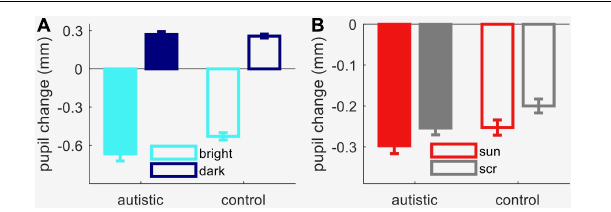
FIGURE 3 | Results from Experiment 2 (autistic and comparison children). (A) Peak pupil response to luminance increments and decrements, averaged across observers in each group. (B) Peak pupil response to sun pictures and meaningless images (“scrambled”), averaged across observers in each group. In both panels, error bars show s.e.m. across